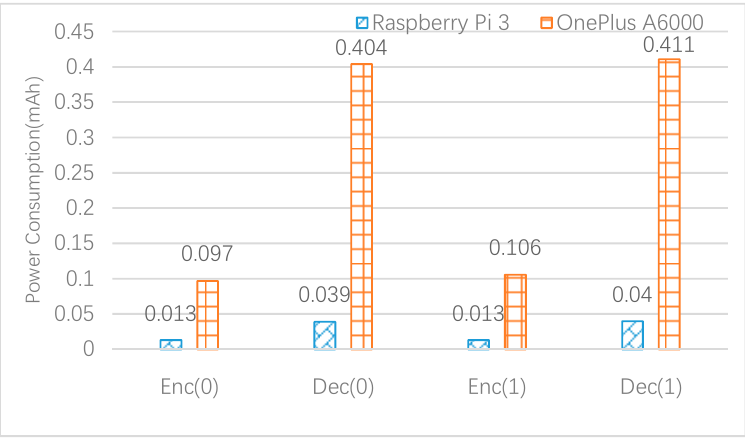
Figure 6. Algorithms’ energy consumption on Raspberry Pi 3 and OnePlus A6000 smartphone.